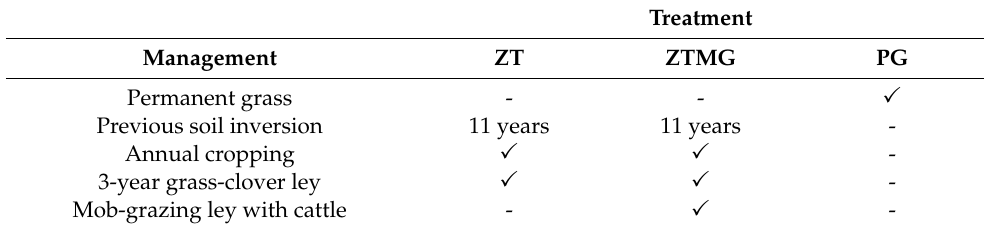
Table 1. Summary of management for the three treatments.